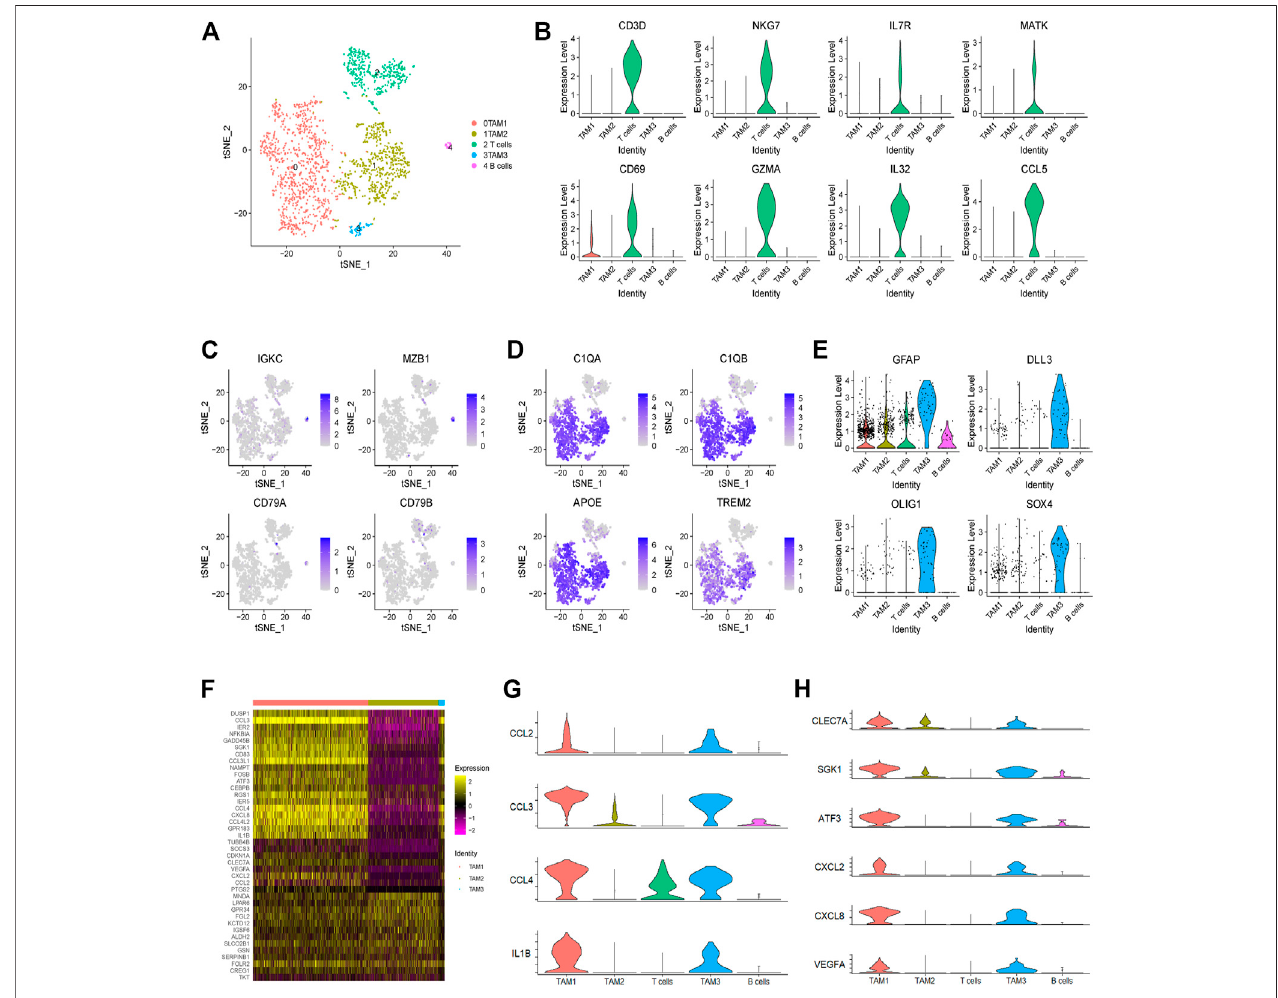
FIGURE2| Landscapeofin fi ltrating immunecellsinaglioma. (A) Thet-SNE plot showing 1,765immunecellscolored bycelltypes. (B) Theviolinplot showing the CD3D, NKG7, IL7R, MATK, CD69, GZMA, IL-32 and CCL5 expression levels in each cluster. (C) The t-SNE plot showing the expression levels of B cell markers (IGKC, MZB1, CD79A and CD79B) in individual cells. (D) The t-SNE plot showing the expression levels of universal TAM markers of (C1QA, C1QB, APOE and TREM2) in individual cells. (E) The violin plot showing the expression levels of tumor cell markers (GFAP, DLL3, OLIG1 and SOX4) in each immune cell cluster. (F) Heatmap showing the differential gene expression of three TAM clusters based on the average Log2 (fold change). (G) The violin plot showing the expression levels of M1 macrophage-related genes (CCL2, CCL3, CCL4 and IL1B) in each cluster. (H) The violin plot showing the expression levels of M2 macrophage-related genes (CLEC7A, SGK1, ATF3, CXCL2, CXCL8 and VEGFA) in each cluster.